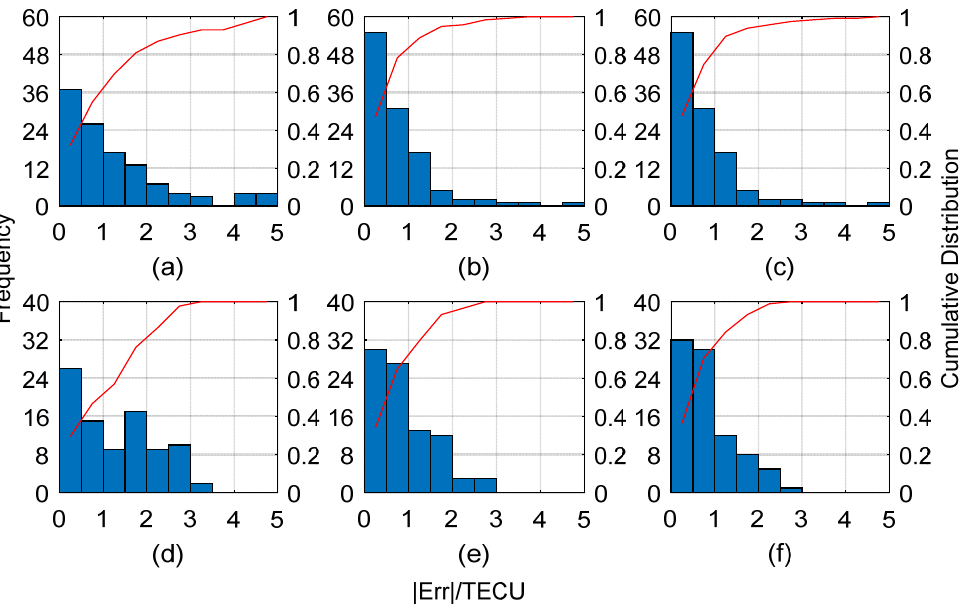
Figure 7. Residuals distribution statistics. ( a – c ) Residuals of polynomial (POLY), back propagation neural network combined with POLY (PBNN-P), and Support Vector Machine Polynomial (SVM-P) at 3:00 UTC with 115 samples. ( d – f ) Residuals of POLY, PBNN-P, and SVM-P at 19:00 UTC with 88 samples.